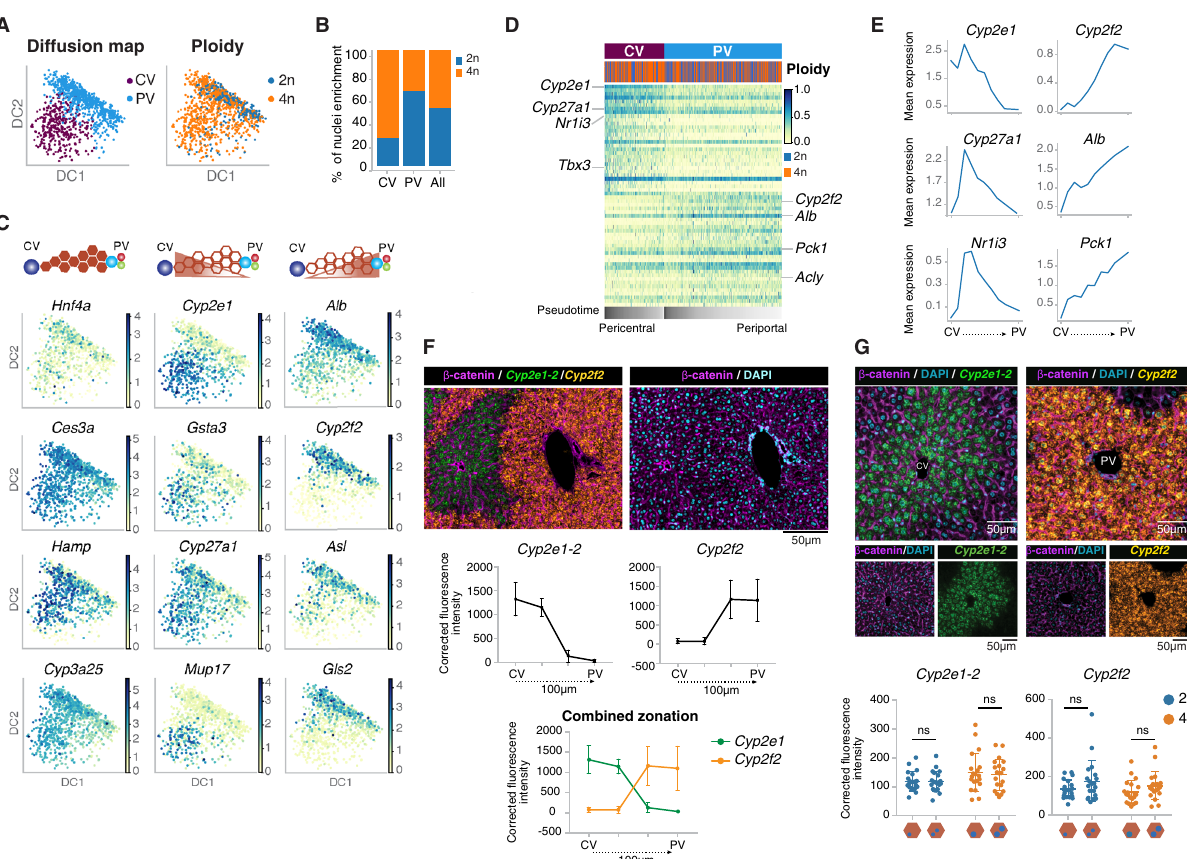
Fig. 5 Pseudospatial ordering of hepatocytes along the liver lobe shows functional crosstalk between ploidy and zonation. A Diffusion map based on zonation markers, colored by annotated zones (left) and ploidy (right). B Bar plot showing a higher percentage of nuclei in the pericentral cluster in comparison to the periportal cluster, colored by ploidy. C Diffusion maps colored by the expression of zonation marker genes, for representative non- zonated genes ( Hnf4a , Ces3a , Hamp , and Cyp3a25 ), pericentral genes ( Cyp2e1 , Gsta3 , Cyp27a1 , and Mup17 ), and periportal genes ( Alb , Cyp2f2 , Asl , and Gls2 ). D PAGA path heatmap showing the top 30 differentially expressed genes per zone between the periportal (PV) and pericentral (CV) clusters of nuclei, where 4n hepatocytes are enriched in the CV zone (colored by log-transformed, normalized counts). E Line plots depicting the mean expression of representative zonation markers along the diffusion pseudospace vector ordered from CV to PV within a liver lobule. F Representative image of IF/RNA- FISH co-detection analysis, showing expression levels of Cyp2e1- 2 (green) and Cyp2f2 (yellow) mRNA in a liver lobule ( n = 3). The fl uorescence intensity of each gene was calculated and normalized against background intensity. The corrected fl uorescence intensity is plotted against a linear distance (100 µ m) from CV to PV. G Corrected fl uorescence intensity of Cyp2e1-2 and Cyp2f2 signals were categorized according to 2n or 4n mononucleated or binucleated hepatocytes, determined by b-catenin (magenta) and 4 ′ ,6-diamidin-2-phenylindol (DAPI; cyan) staining. No signi fi cant changes were detected between ploidy levels or the number of nuclei from an unpaired t -test analysis (ns not signi fi cant). F , G Data points are expressed as mean ±